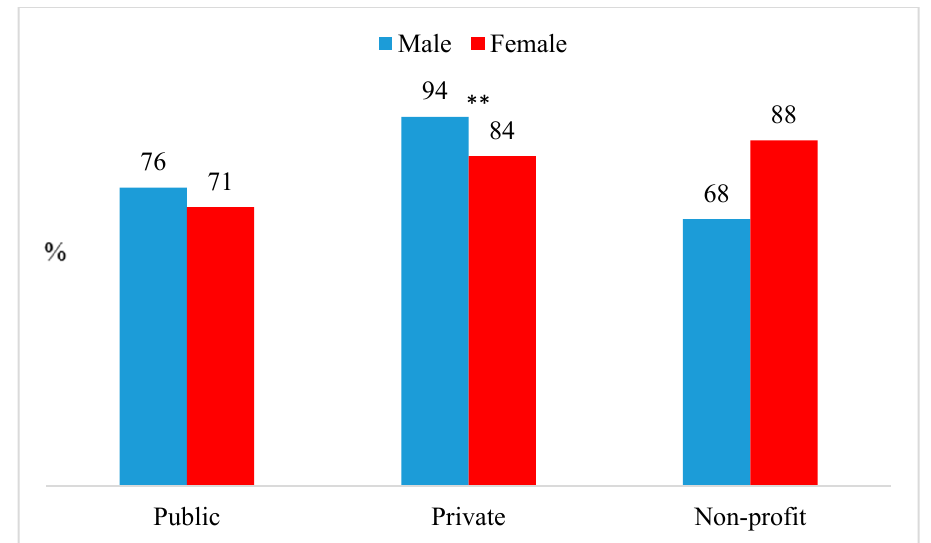
Figure 2. Proportion of doctoral graduates with a permanent job by gender and employment sector in 2013 (** p < 0.01).